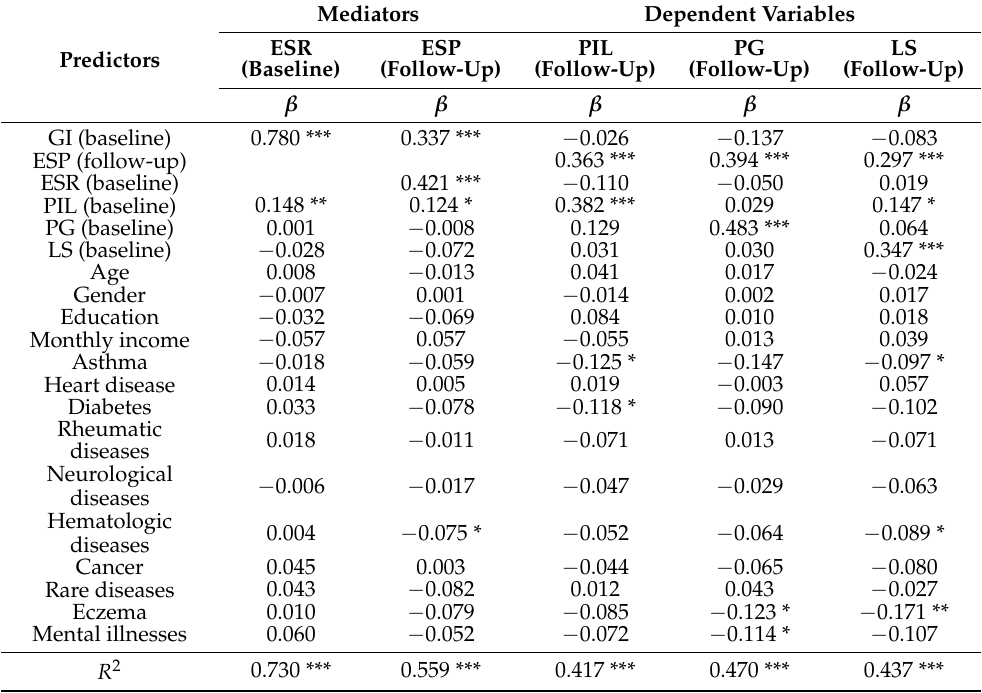
Table 5. Standardized coefficients for direct effects of the path